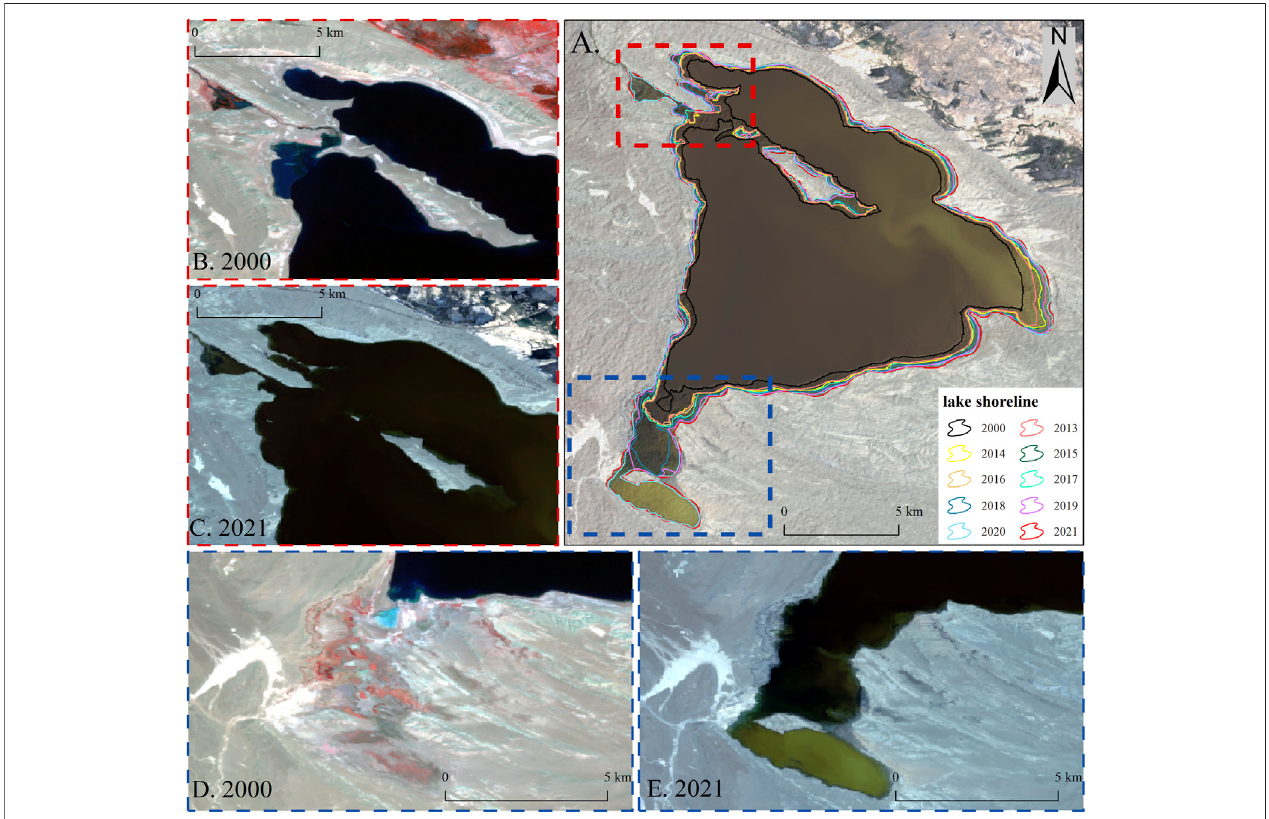
FIGURE7| ComparisonofareachangesofTuosuLake. (A) Sceneofthewholelake. (B) and (D) showthelocalsceneofTuosuLakein2000. (C) and (E) showthe local scene of Tuosu Lake in 2021. The base map of (A) and (C) – (E) is the Landsat OLI image (RGB); (B) is the Landsat ETM+ image (RGB).